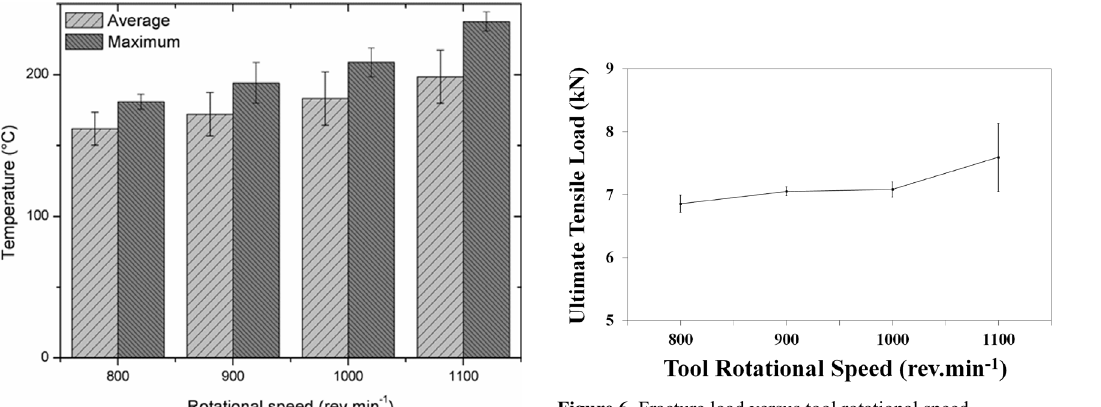
Figure 6. Fracture load versus tool rotational